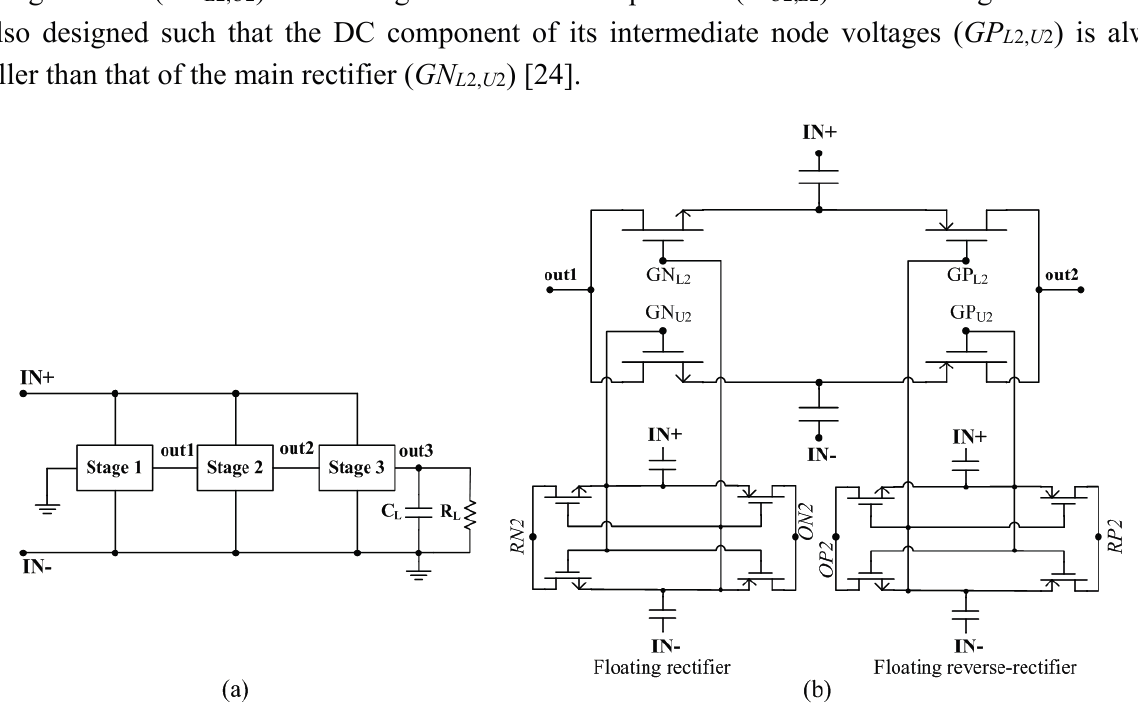
Figure 5. Proposed rectifier; ( a ) entire architecture; ( b ) circuit schematic of the second